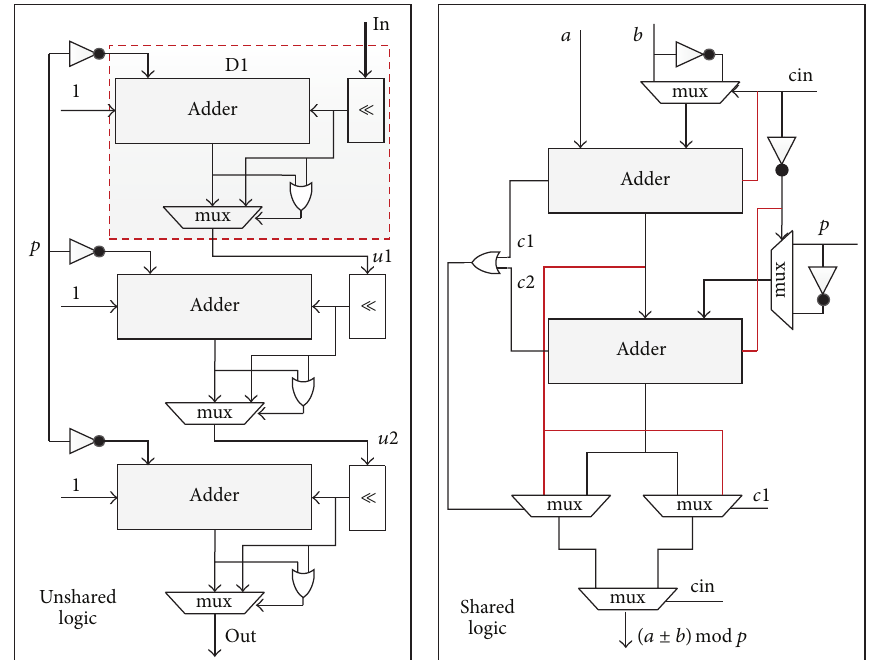
Figure 2: Shared and unshared logic